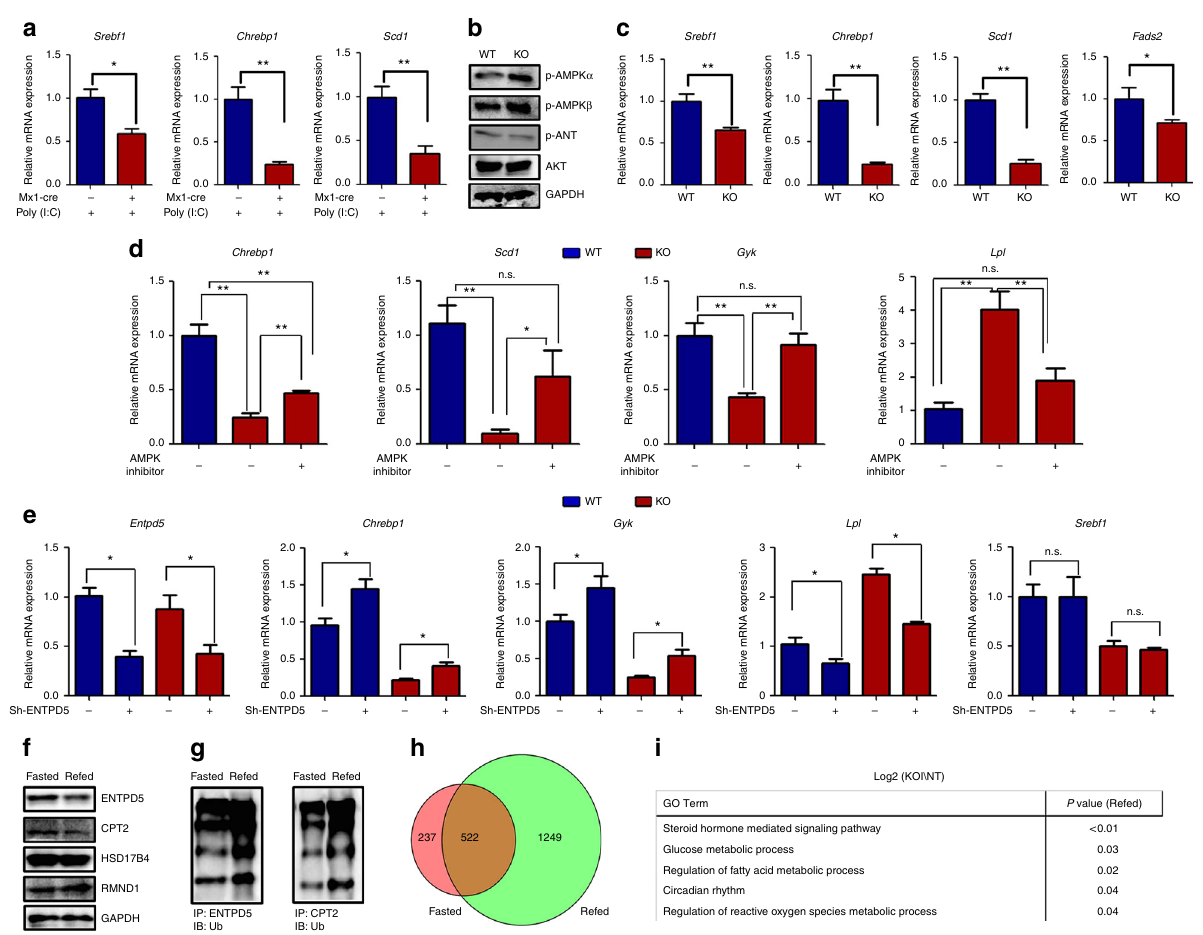
Fig. 6 HRD1-mediated ubiquitination reprograms liver metabolic response partially through ENTPD5-AMPK pathway overactivation. a Relative mRNA of Srebf1 , Chrebp1 , and Scd1 of HRD1 fl ox/ fl ox (WT) and HRD1 fl ox/ fl ox Mx1-Cre + mice 2 days after polyI:C injection ( n = 5 for each group). b , c WT and HRD1